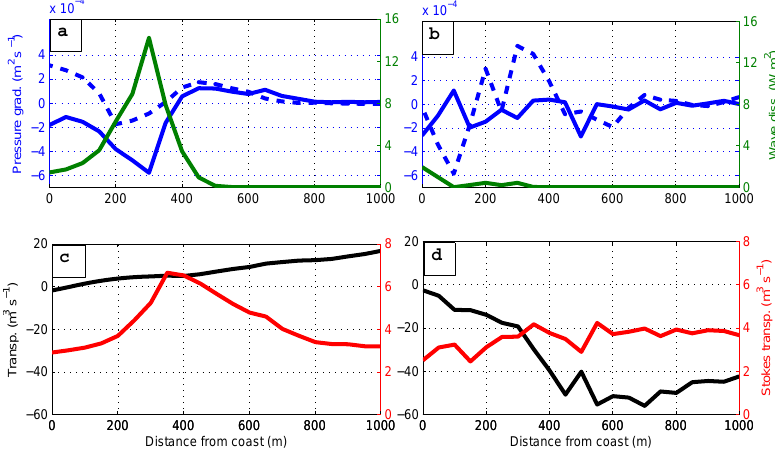
Figure 12. Cross-shore sections 1 (a, c) and 2 (b, d) of the wave contributions to the nearshore momentum balance for the WAVECOUPLE experiment 2. The section positions are shown in Fig. 9d. While section 1 is over the region of large wave-breaking energy dissipation, the section 2 is in the region of the intense return flow observed in the cross-shore velocity map in Fig. 7. The pressure gradient (continuous line: cross-shore; dashed line: alongshore) due to wave setup is shown in blue, the wave dissipation due to depth-induced wave breaking in green, the vertically integrated Stokes drift transport in red, and the total wave-induced cross-shore transport in black. The total wave-induced cross-shore transport was obtained subtracting the NOWAVE quasi-Eulerian velocities from the WAVECOUPLE velocities.